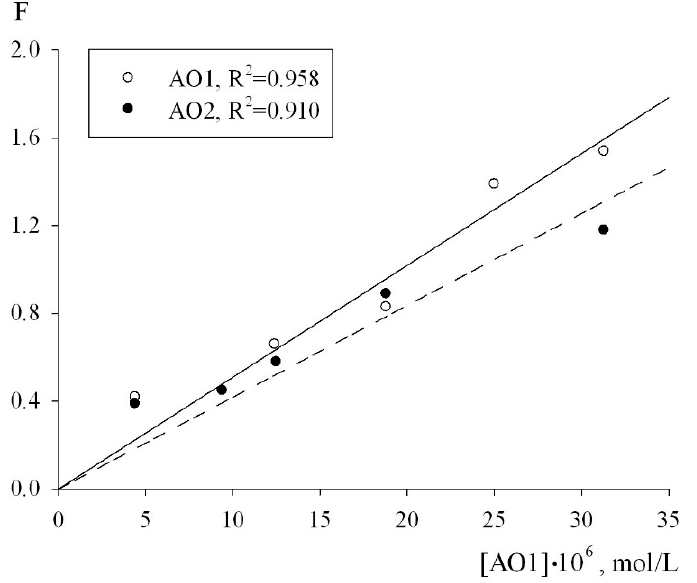
Figure 6. Dependence of the inhibition efficiency parameter on the concentration of AO1 and AO2, V i = 1 · 10 − 7 M/s, T = 348 K.